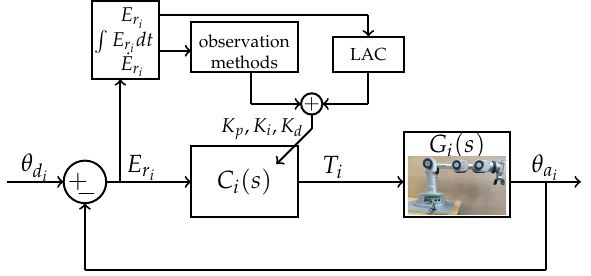
Figure 2. Block diagram of LAC